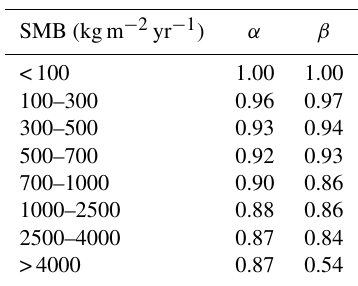
Table 1. Proposed values for the accumulation constants α and β used in our monthly firn compaction model. The constants are de- pendent on the accumulation rate and have been adapted to a best fit.